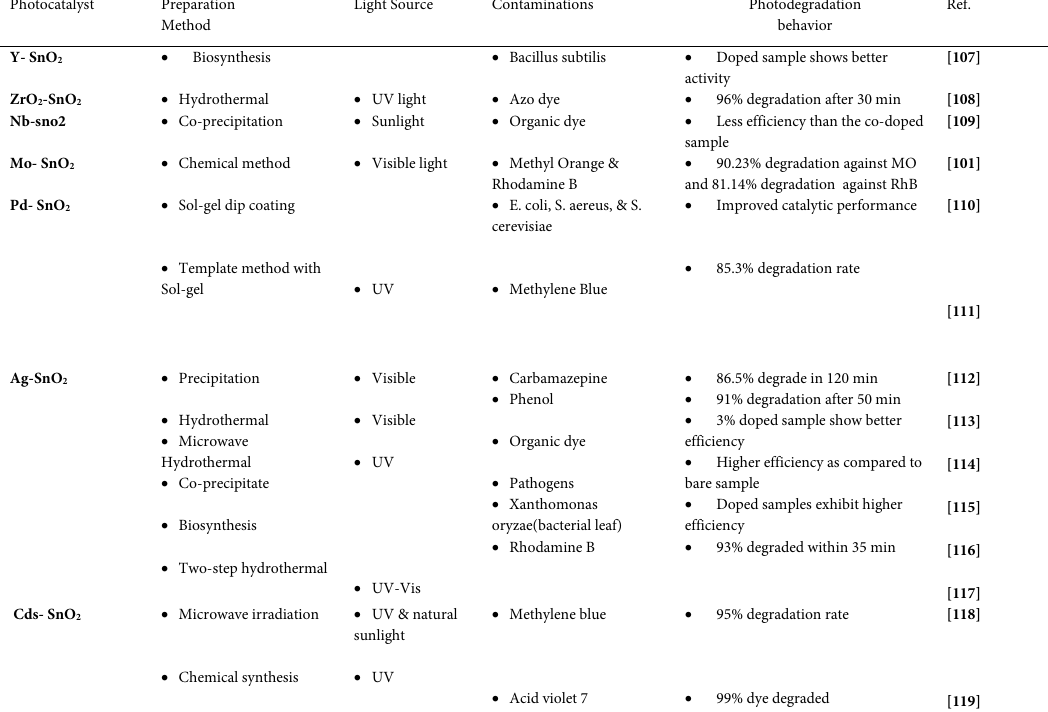
semiconductor 2